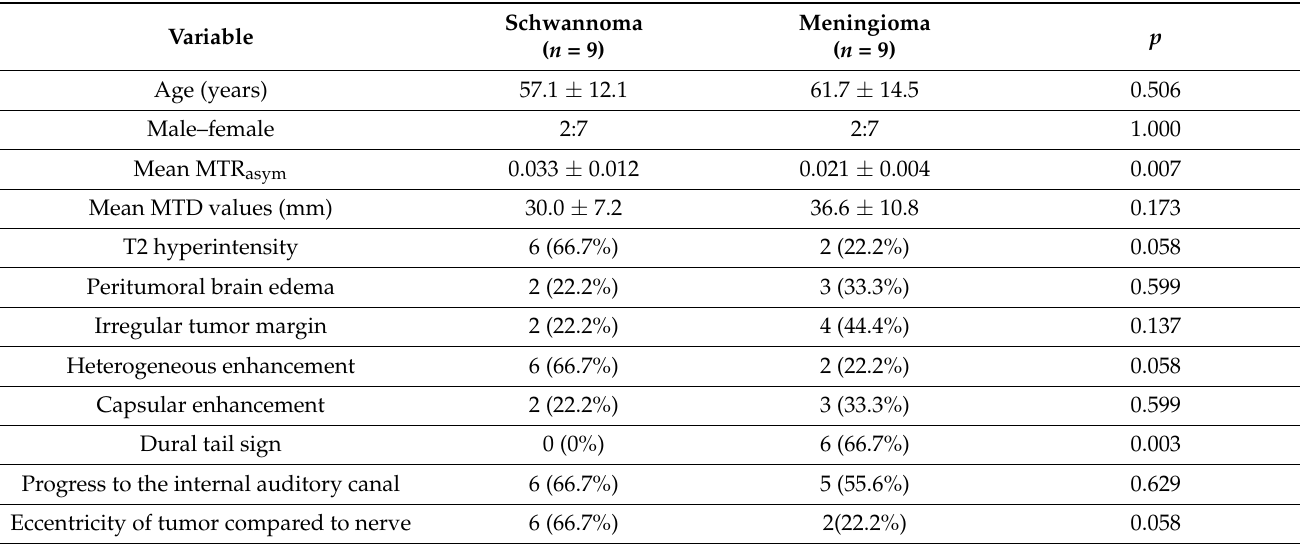
Table 1. Comparison of demographic and clinical characteristics and imaging findings between patients with schwannomas and